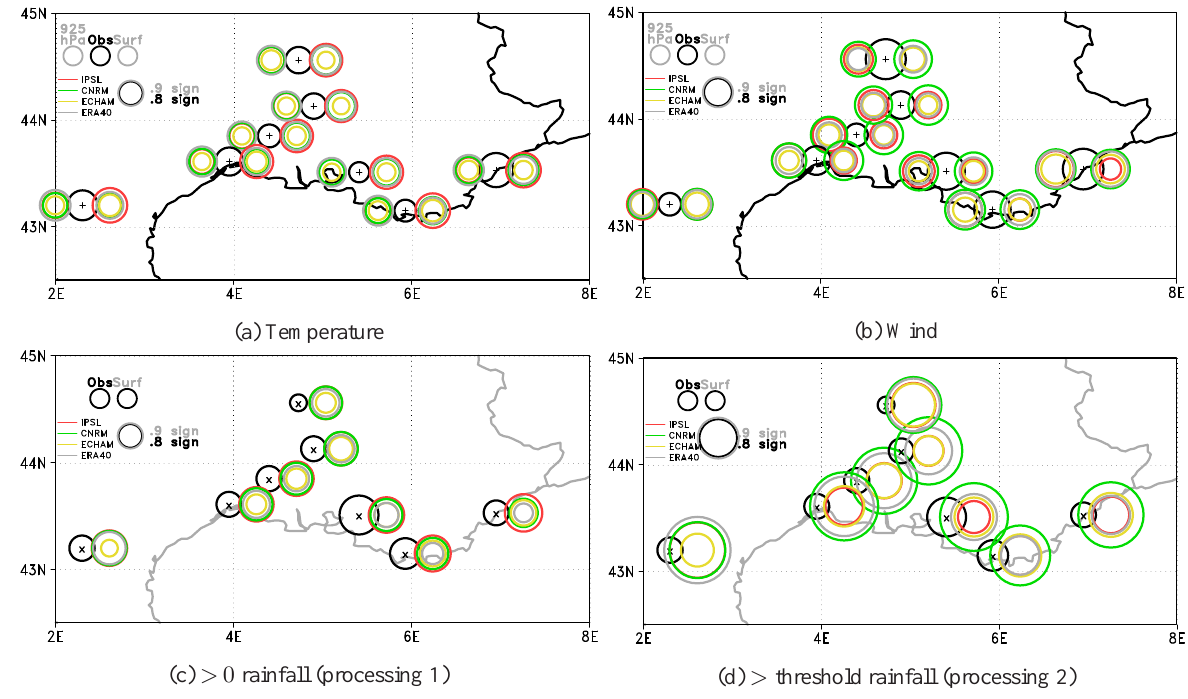
Fig. 2: KS scores (proportional to the circle areas) comparing the CDFs over the evaluation period (1991-2000 for temperature and precipitation; 1996-2000 for wind speed) and over the calibration period (1981-1990 for temperature and precipitation; 1991-1996 for wind speed) for temperature (a), wind speed (b), rainfall (processing 1 in c; processing 2 in d; see details in the text for the definition of rainfall processing). In panels a and b, the KS scores for the observations are displayed in the middle, for the model using the 925 hPa data on the left, and for the surface fields on the right. In panels c and d, the KS scores for the observations are displayed on the left and for the model on the right. The KS scores are computed over the eight stations using IPSL (red), CNRM (green), ECHAM5 (yellow) and ERA reanalyses (grey).